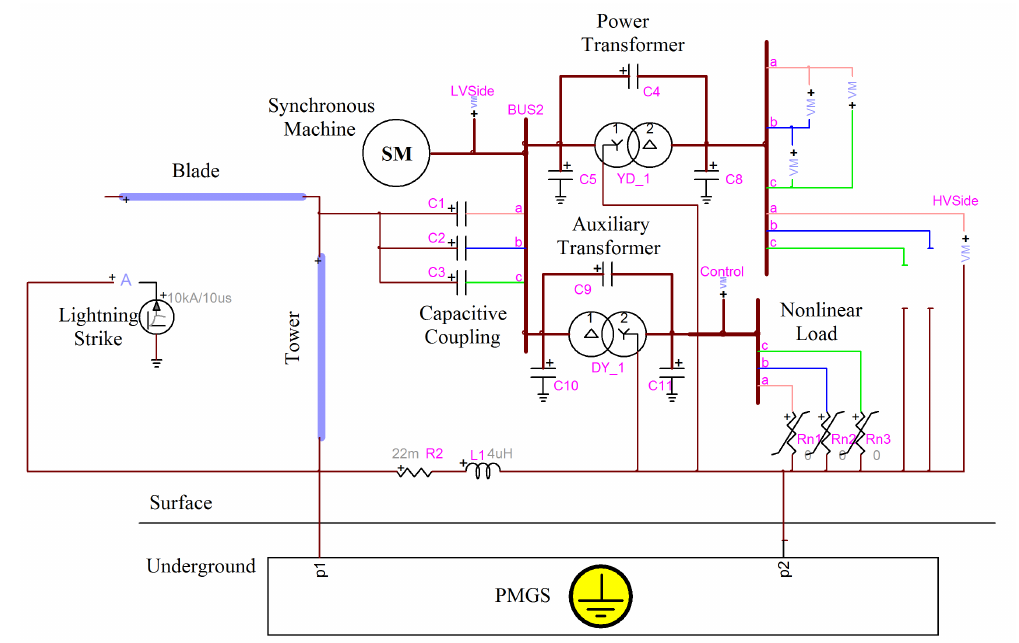
Figure 2. EMTP-RV circuit of the simulated single wind turbine with PMGS.